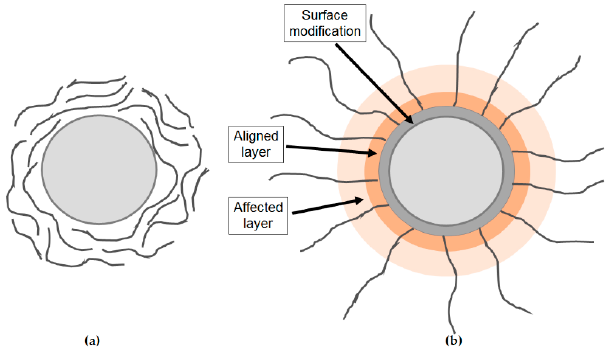
Figure 15. Polymer Chain Alignment Model by Andritsch: nanoparticles ( a ) without and ( b ) with surface modifications. (Redraw and adapted figure from [86]).